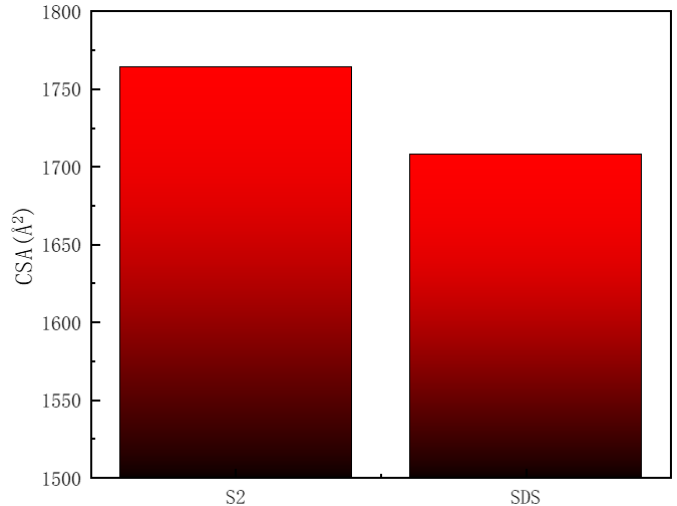
Figure 5. CSA of different S2 and SDS.